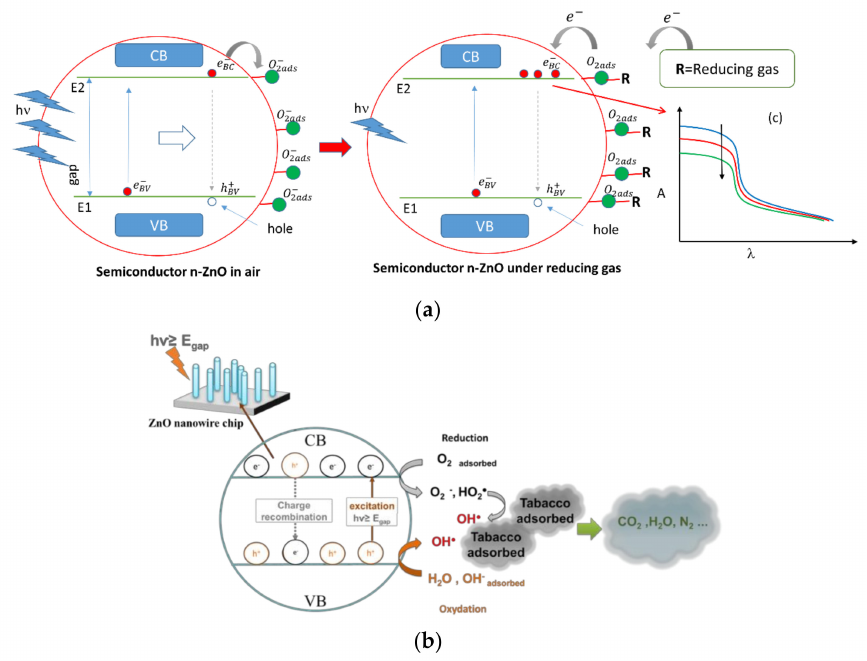
Figure 3. ( a ) Process of air purification by adsorption using ZnO-NWs, ( b ) Process of air purification by photocatalysis using ZnO-NWs under UV light